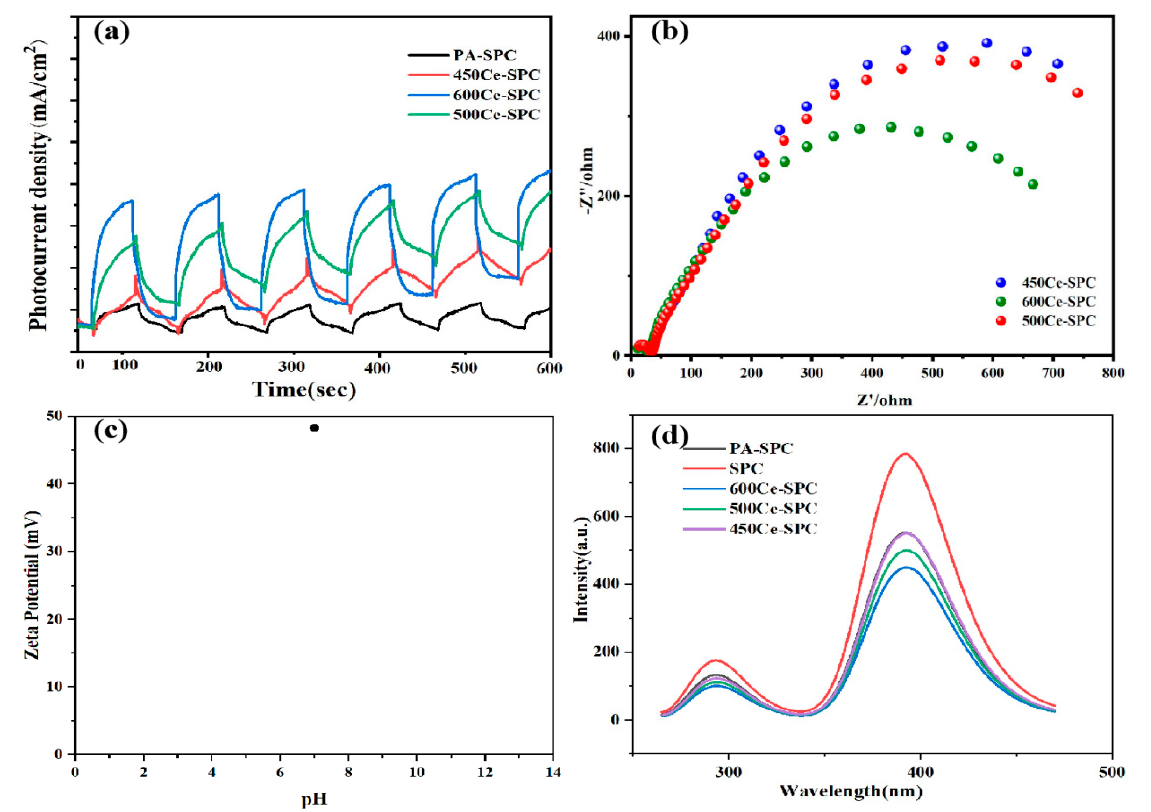
Figure 5. ( a ) Photocurrent responses; ( b ) EIS Nyquist plots; ( c ) zeta potential of 600 Ce-SPC; ( d ) photoluminescence spectra of SPC, PA-SPC, 600 Ce-SPC, 500 Ce-SPC and 450 Ce-SPC nanocomposites.